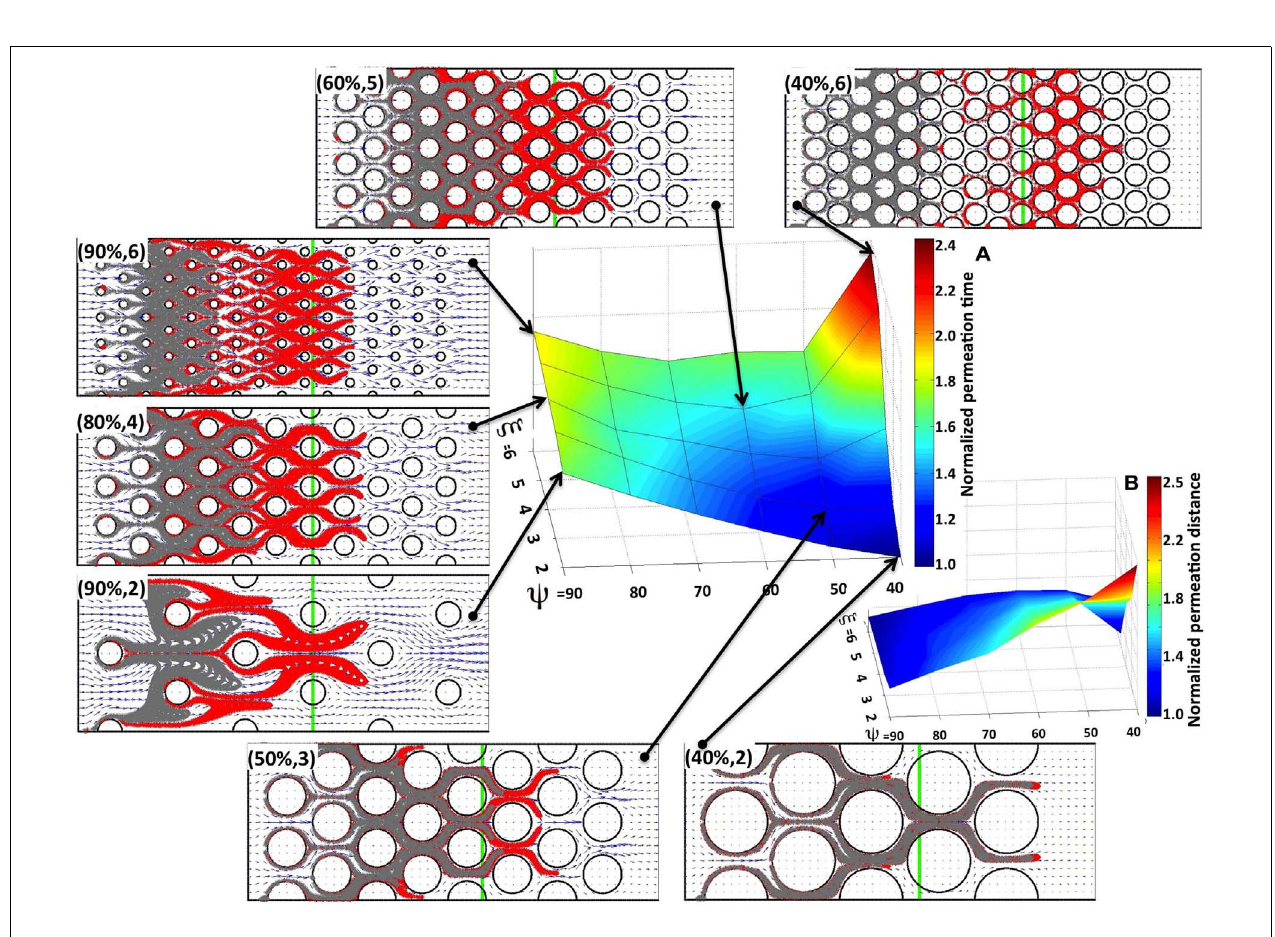
cellular density ( ψ , ξ ). Seven specific tissue configurations of indicated cellular porosity and cellular density are shown in each case.The locations of drug particles at a fixed time from (B) are shown in gray, and their final positions at the permeation times from (A) are shown in red.The green vertical lines indicate the fixed distance at which the permeation time is